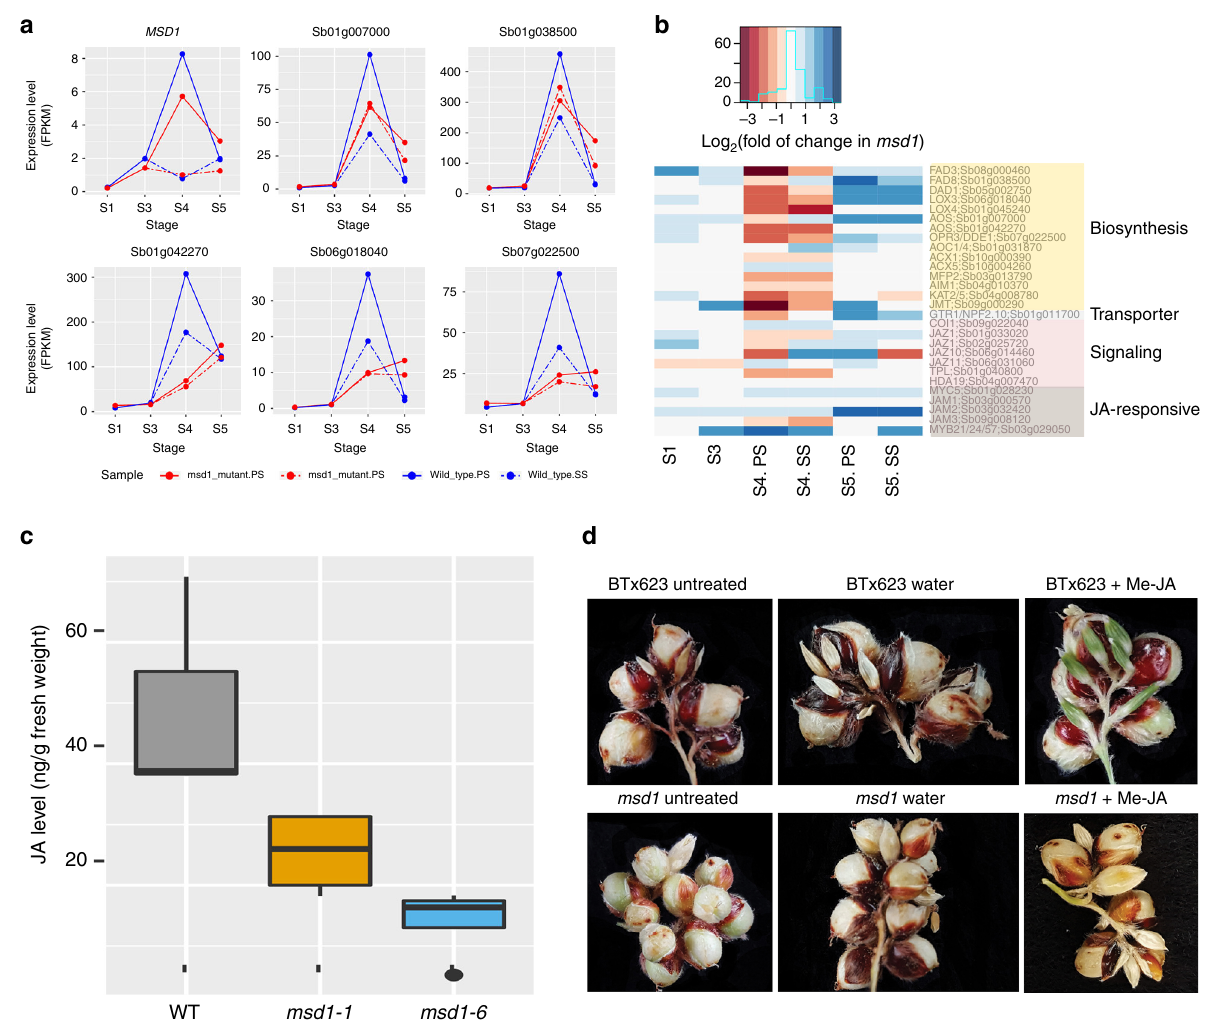
Fig. 4 MSD1 regulates the JA pathway and exogenous Me-JA rescues the msd1 phenotype. a Expression pattern of MSD1 and fi ve putative target genes identi fi ed in the RNA-seq analysis that are involved in jasmonic acid (JA) biosynthesis (as determined by orthologs of Arabidopsis thaliana JA pathway). The blue lines depict pattern of expression in WT, whereas red lines represent expression in the msd1-1 mutant. At stages 4 and 5, solid and dotted lines indicate PS and SS, respectively. The expression level of MSD1 clearly differed between SS and PS in stage 4 in WT. MSD1 was differentially expressed between WT and msd1 only at stage 4 in PS. For the fi ve putative target genes, the two red lines almost overlap with each other, indicating that in the msd1 mutant, the expression levels of these three genes were similar in PS and SS. b Heatmap of fold change in expression of sorghum orthologs of the Arabidopsis JA pathway genes in msd1 mutants. Genes involved in biosynthesis were downregulated at stage 4 in PS of msd1 . c Box plot showing JA concentrations from fi ve young panicle samples from each of two msd1 mutants and WT (BTx623). Lines from bottom to top represent minimum, fi rst quartile, median, third quartile, and maximum; dots indicate outliers. JA levels were lower in the two mutants than in WT. d Photograph of adaxial side of a secondary branch of in fl orescence during exogenous JA treatment of WT and msd1-1 plants. The msd1-1 mutant reverted to the WT phenotype